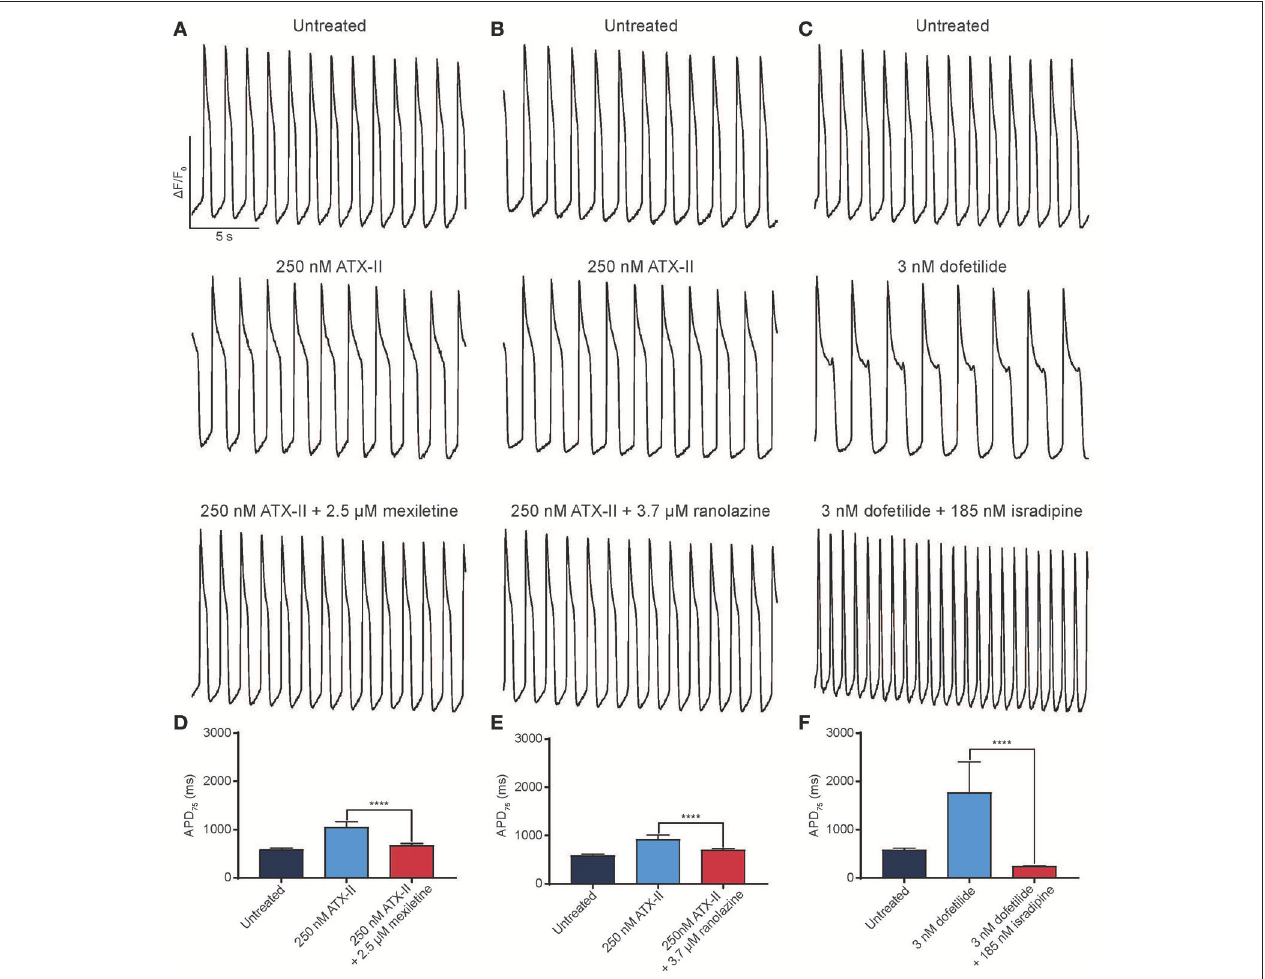
FIGURE 5 | Reversion of drug-induced arrhythmia with antiarrhythmic drugs. (A–C) Representative normalized 1 F/F 0 vs. time plots for normal individual (iCell) hiPSC-CMs treated with 250 nM ATX-II and 2.5 µ M mexiletine (A) or 3.7 µ M ranolazine (B) and 3 nM dofetilide and 185 nM isradipine (C) . (D–F) Quantification of APD 75 for normal hiPSC-CMs treated with ATX-II and mexiletine (D) , ATX-II and ranolazine (E) , dofetilide and isradipine (F) . **** p < 0.0001 using a one-way ANOVA test. n = 3 replicate wells for each condition in all cases. Scale bars indicate time (5s) and 1 F/F 0 (50% of the maximal obtained in each